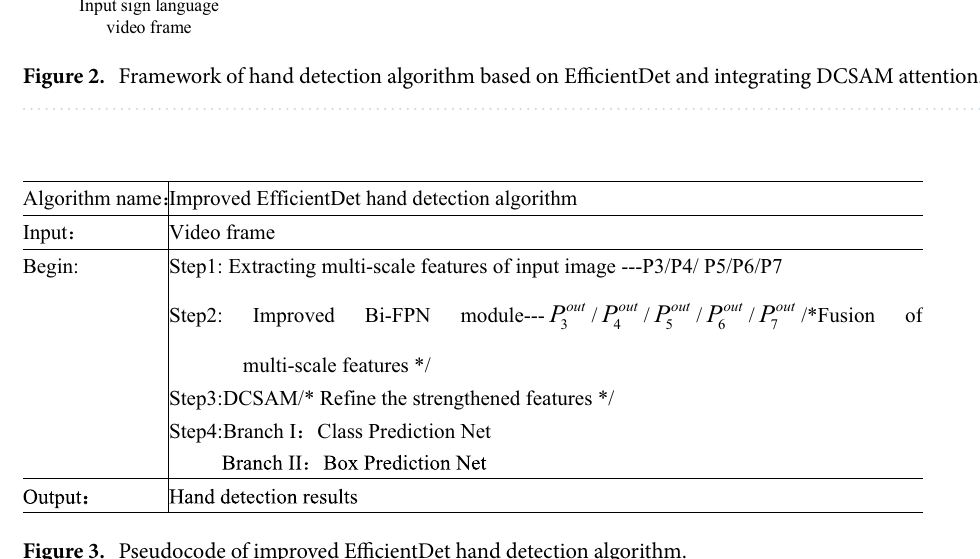
Figure 3. Pseudocode of improved EfficientDet hand detection